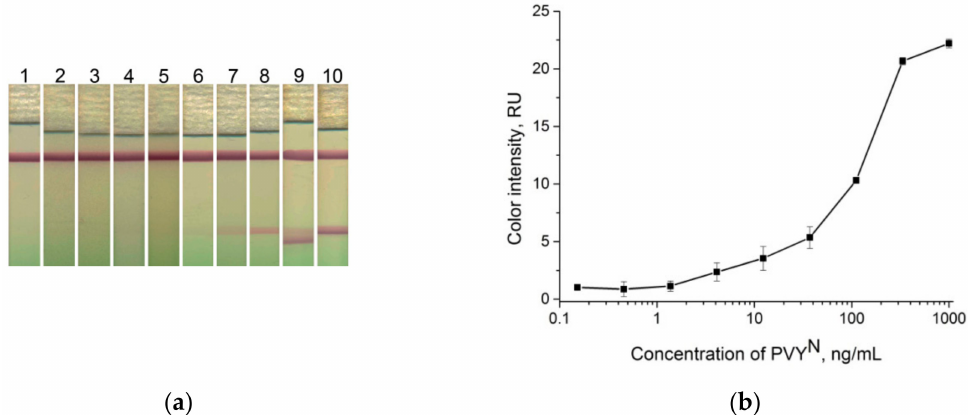
Figure 10. LFIA using PVY N –spiked plant extract, test strips without sample pad. ( a ) Test strip after analysis, test strip 1 is the negative control (0 ng · mL − 1 ), and test strips 2–10 of the PVY N –spiked plant extract concentration: 0.15 ng · mL − 1 , 0.46 ng · mL − 1 , 1 ng · mL − 1 , 4 ng · mL − 1 , 12 ng · mL − 1 , 37 ng · mL − 1 ,